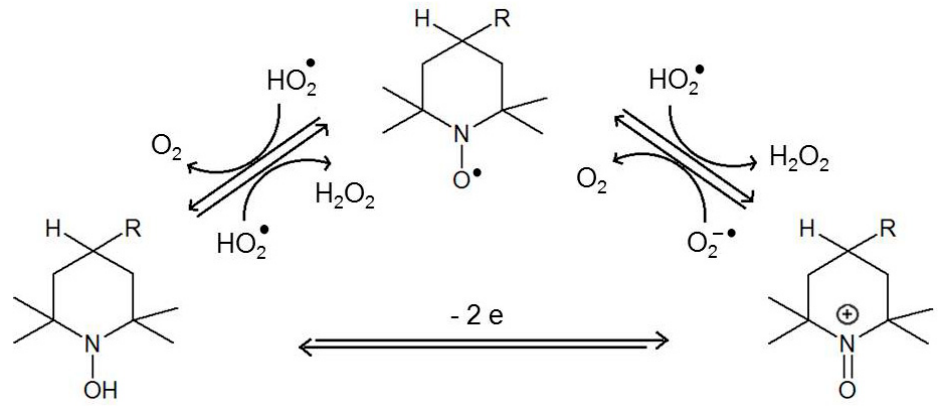
Figure 2. Redox cycle of nitroxides and their SOD-like activity.